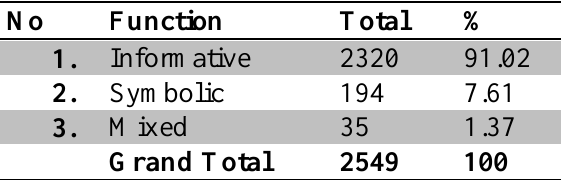
Table 4. The Function of